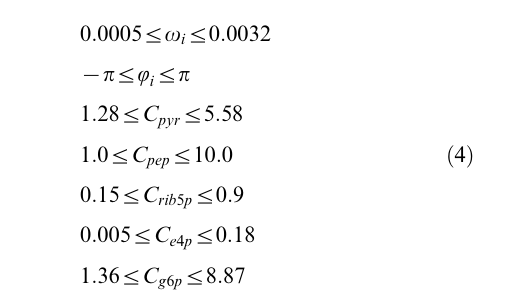
table of all parameters, equations and modified mass balance equations is provided in the supplementary materials (Text